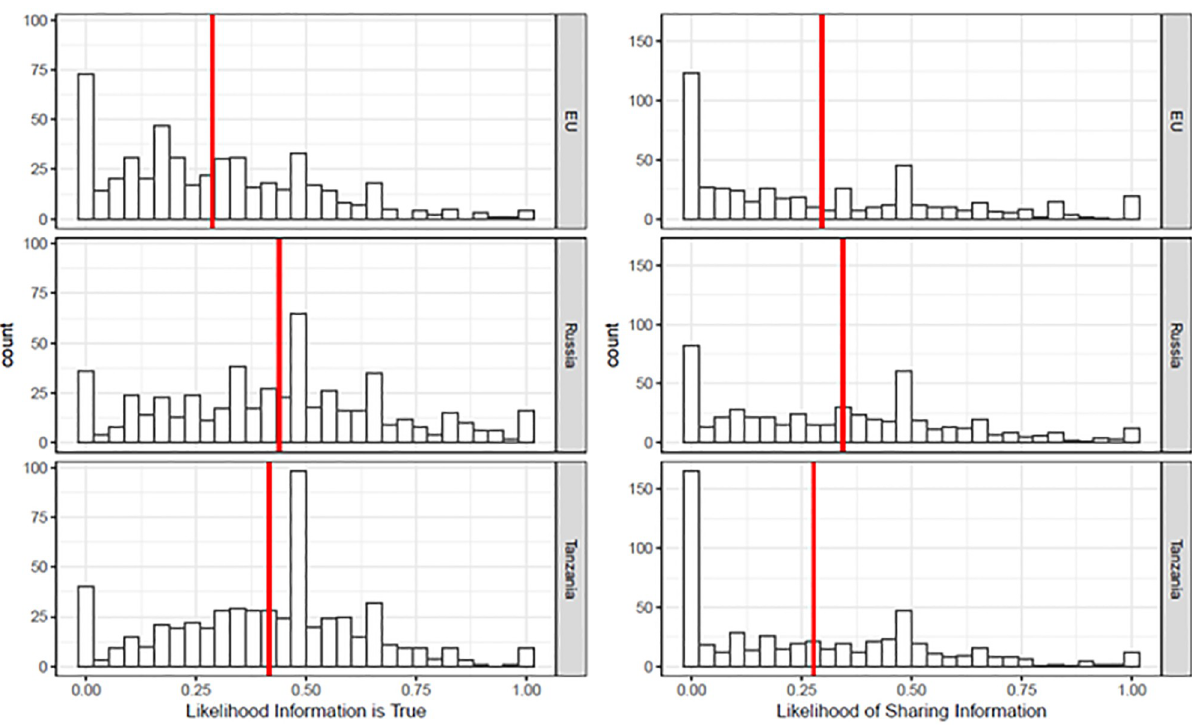
Fig 1. Distribution of beliefs (left) and intentions to share (right) the false news stories by treatment condition: Stories about the EU (top), Russia (middle), and Tanzania (bottom). The red vertical lines give the average value of dependent variables for each condition. The dependent variables range from 0 to 1, with higher values indicating greater beliefs the stories and true and higher intentions to share